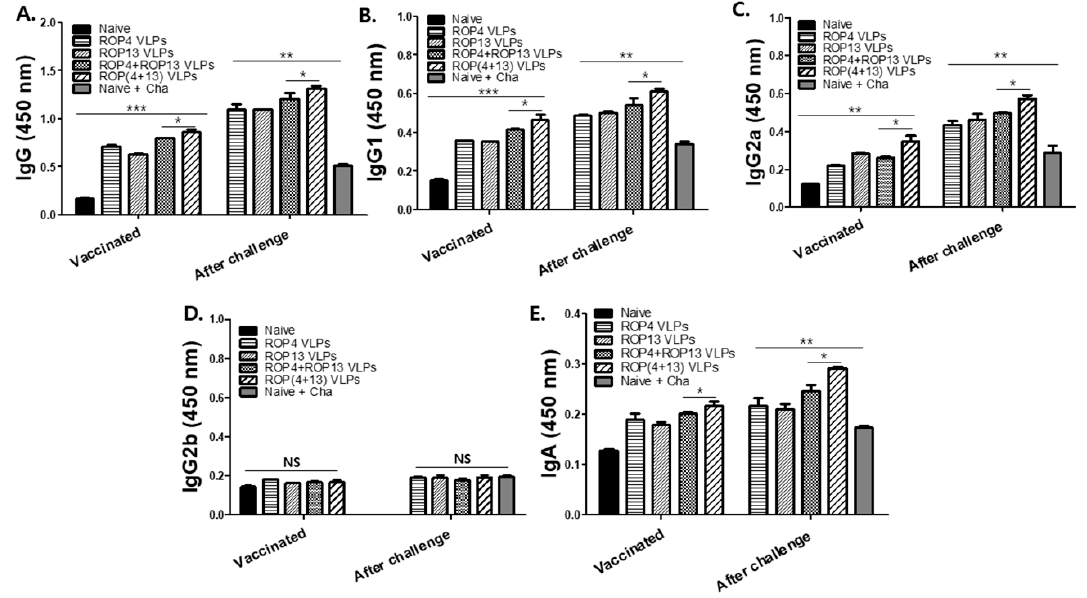
Figure 2. High reactivity to T. gondii -specific antibody response in serum. Ten mice per group were immunized with ROP4 VLPs, ROP13 VLPs, ROP4+ROP13 VLPs and ROP(4 + 13) VLPs. Sera were collected 4 weeks after boost immunization and challenge infection with T. gondii ME49. ELISA plate were coated with T.gondii RH (4ug/mL) and sera (1:50 dilution) were incubated in coated plate after serial dilution. T. gondii -specific IgG antibodies response (( A ), * p < 0.05, ** p < 0.01, *** p < 0.01). T. gondii -specific IgG1 antibody response (( B ), * p < 0.05, ** p < 0.01). T. gondii -specific IgG2a antibody response (( C ), * p < 0.05, ** p < 0.01). T. gondii -specific IgG2b antibody response ( D ). T. gondii -specific IgA antibody response (( E ), * p < 0.05, ** p < 0.01).